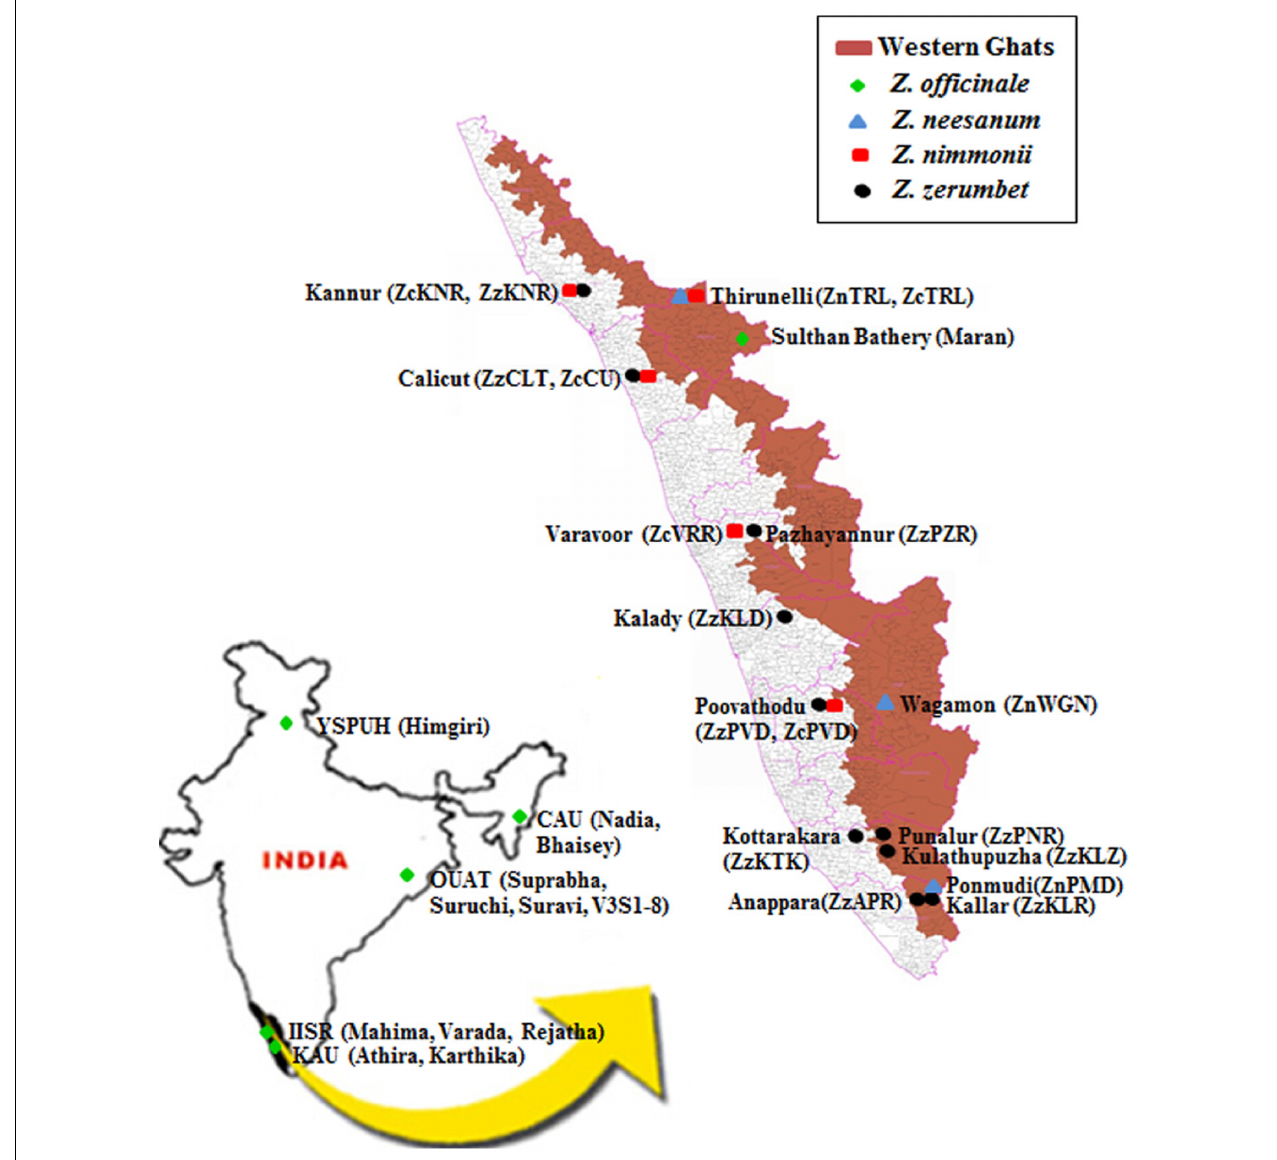
FIGURE 1 | Map indicating the collecting site of populations of wild Zingiber spp. or the cultivars of ginger included in this study. Parentheses represent the name of the populations or cultivars. YSPUH – Dr. Y. S. Parmer University of Horticulture and Forestry, Solan, Himachal Pradesh; CAU –